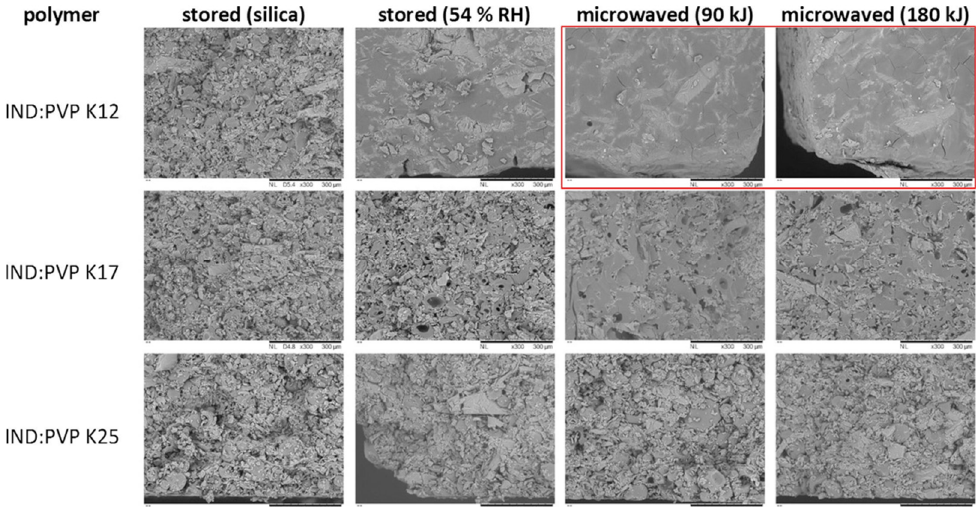
Figure 2. Scanning electron micrographs of the cross section of IND:PVP K12, IND:PVP K17 and IND:PVP K25 compacts after storage under dry conditions, 54% RH and after subsequent processing with 90 kJ and 180 kJ microwave energy. (Reproduced from [46]). The highest extent of pore network reduction is highlighted by the red square.